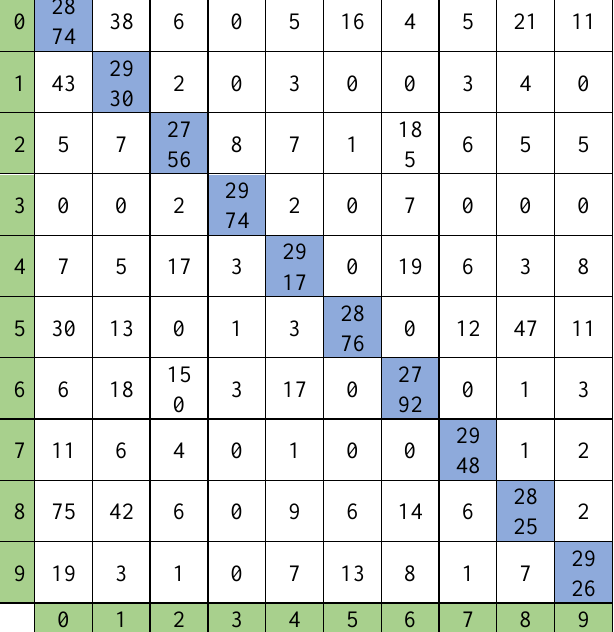
Fig. 9. Confusion matrix of